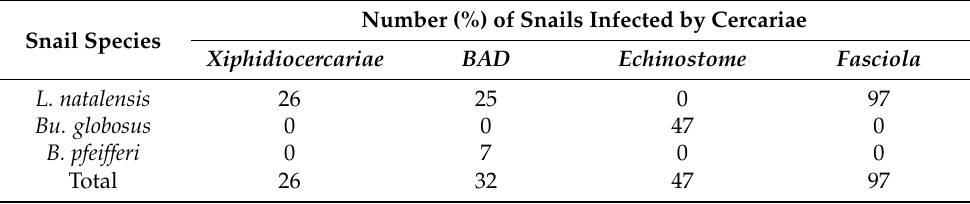
Table 3. Cercarial infection of snail species in the Gilgel Gibe and Meskan districts.